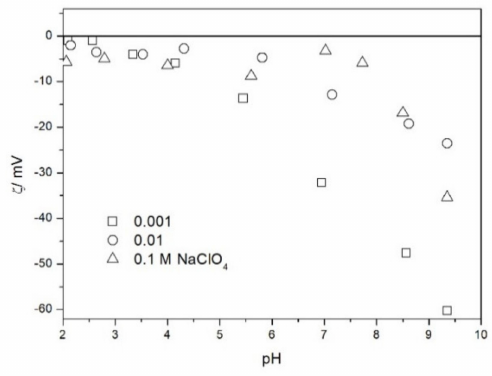
Figure 6. The zeta potential of TeO 2 in NaClO 4